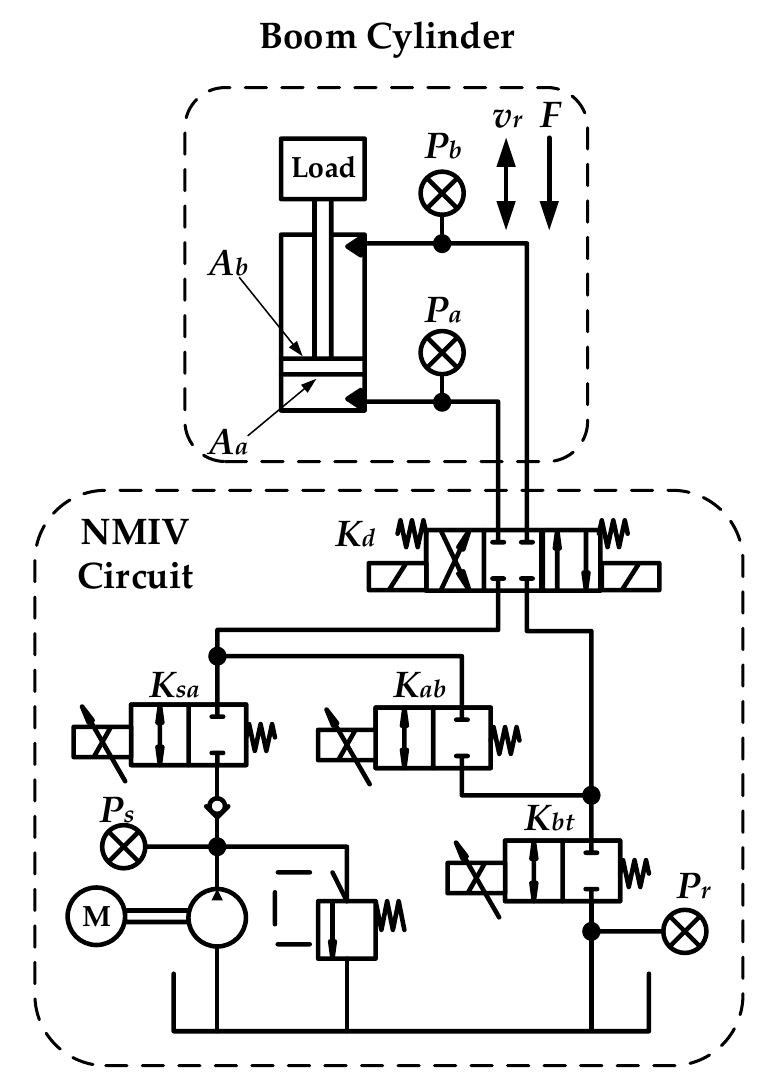
Figure 1. The configuration of the NIMV circuit.